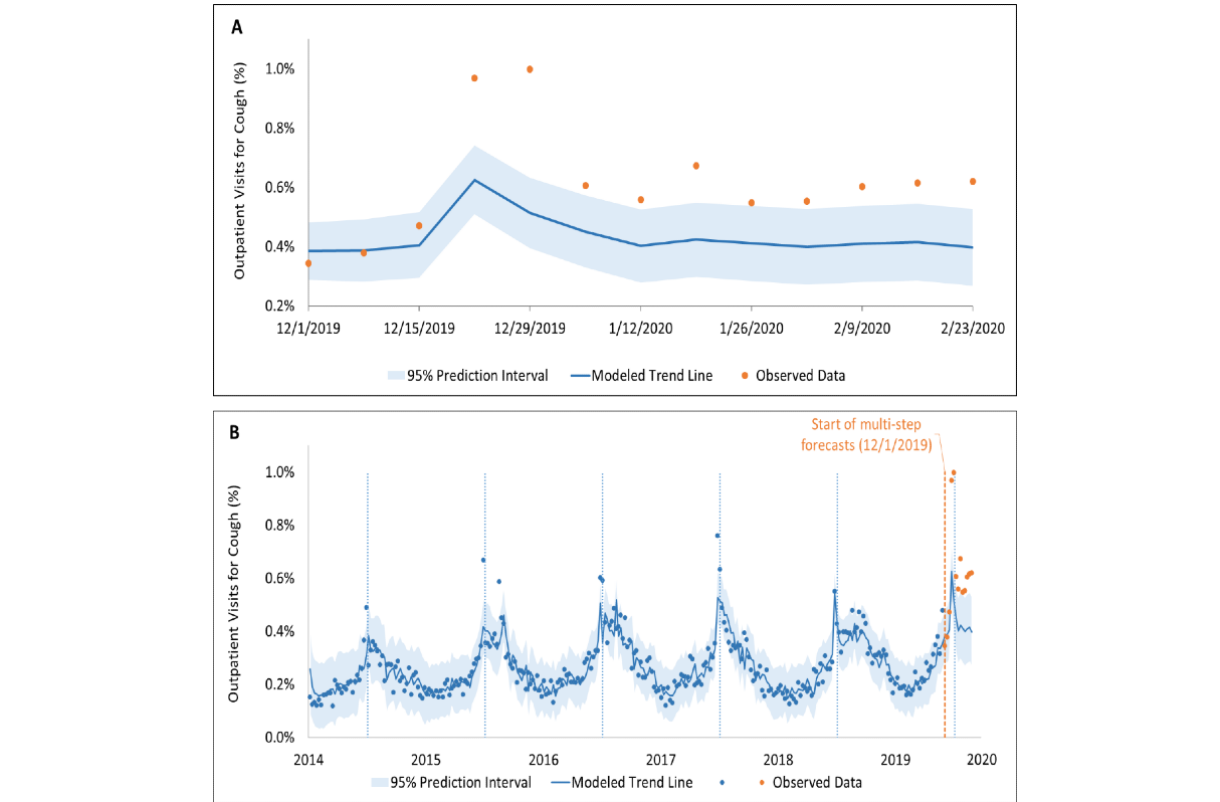
Figure 2. Time series analysis of outpatient data. (A) Forecast, with 95% prediction intervals, of expected rates of outpatient presentations for cough (based on time-series analyses of the previous 5 years), with observed data for each week shown for December 1, 2019, to February 29, 2020. (B) Time-series analysis of outpatient data.